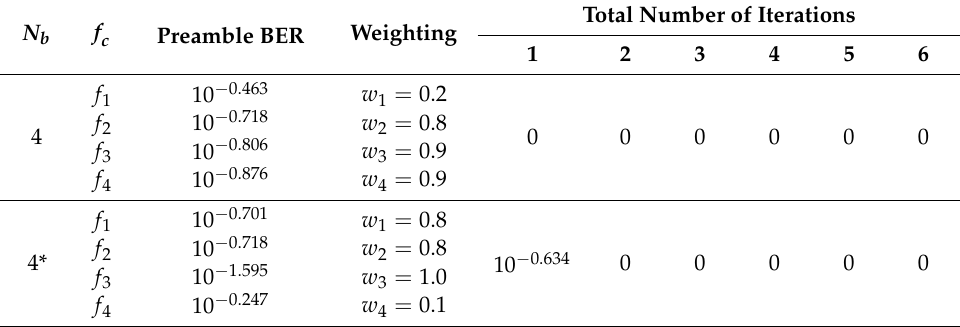
Table 3. Experimental results for preamble error rate-based threshold-setting algorithm. Total Number of Iterations N b f c Preamble BER Weighting 1 2 3 4 5 6 10 −